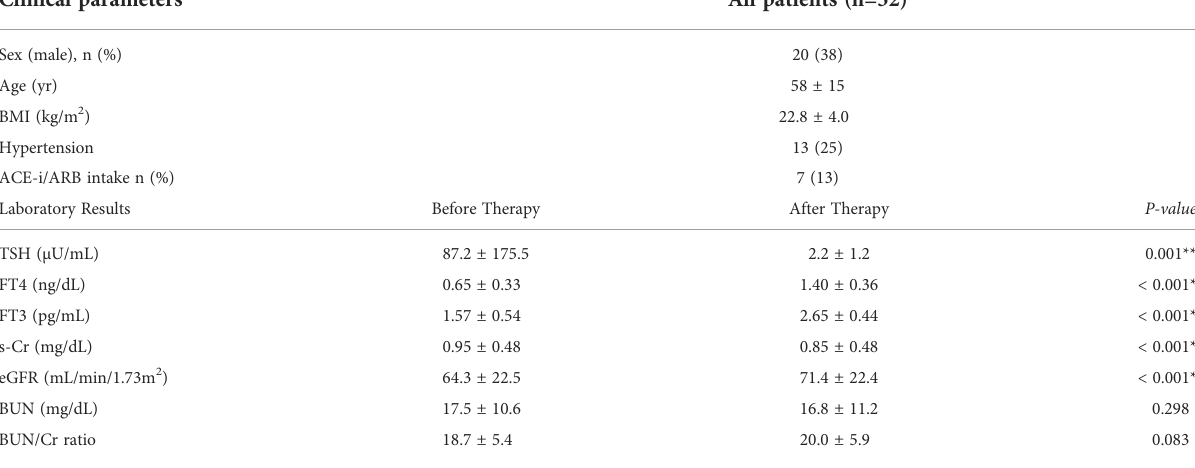
TABLE 4 Clinical characteristics before and after treatment in hypothyroidism. Clinical parameters